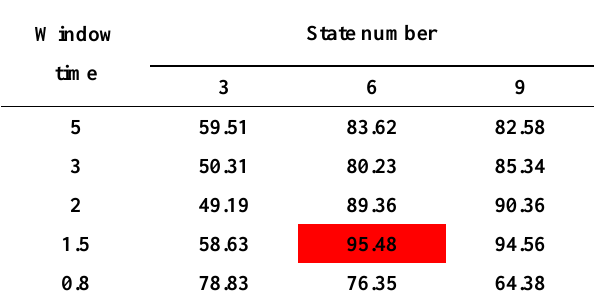
Table 2 Accuracy of recognition of LCL intention with different state number and window